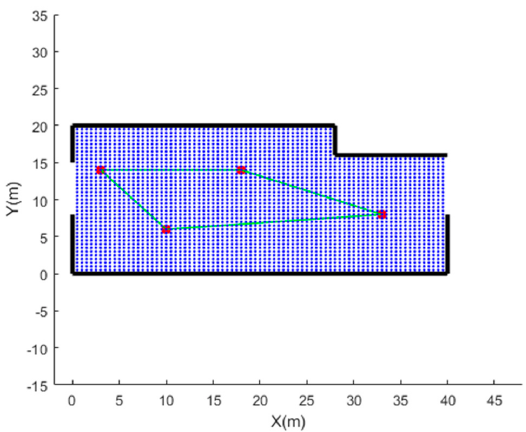
Figure 4 . Selected points (blue points) in the developed indoor two-dimensional (2D) simulation scenario. The red dots are ANTs, the green lines are connections of ANTs.